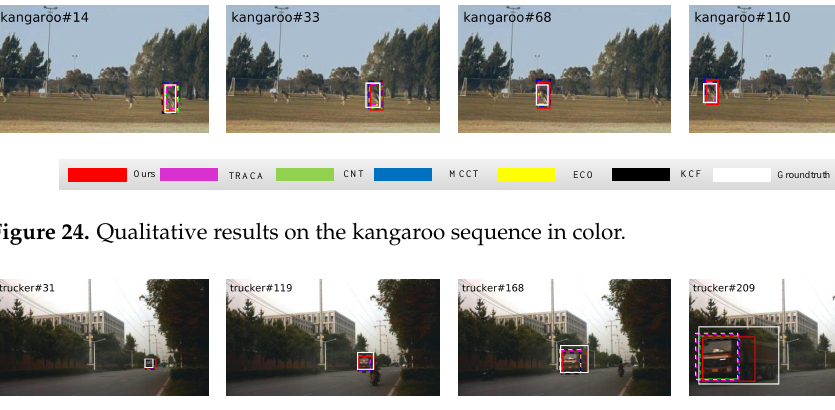
Figure 23. Qualitative results on the car sequence in color.